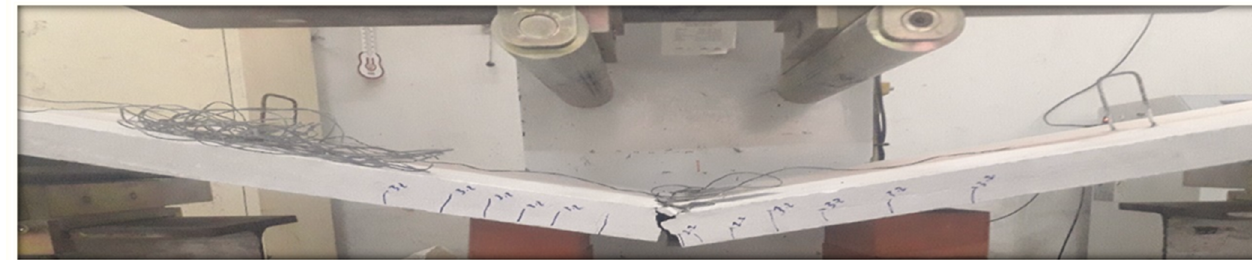
Figure 14. Failure of SRC tested slab.